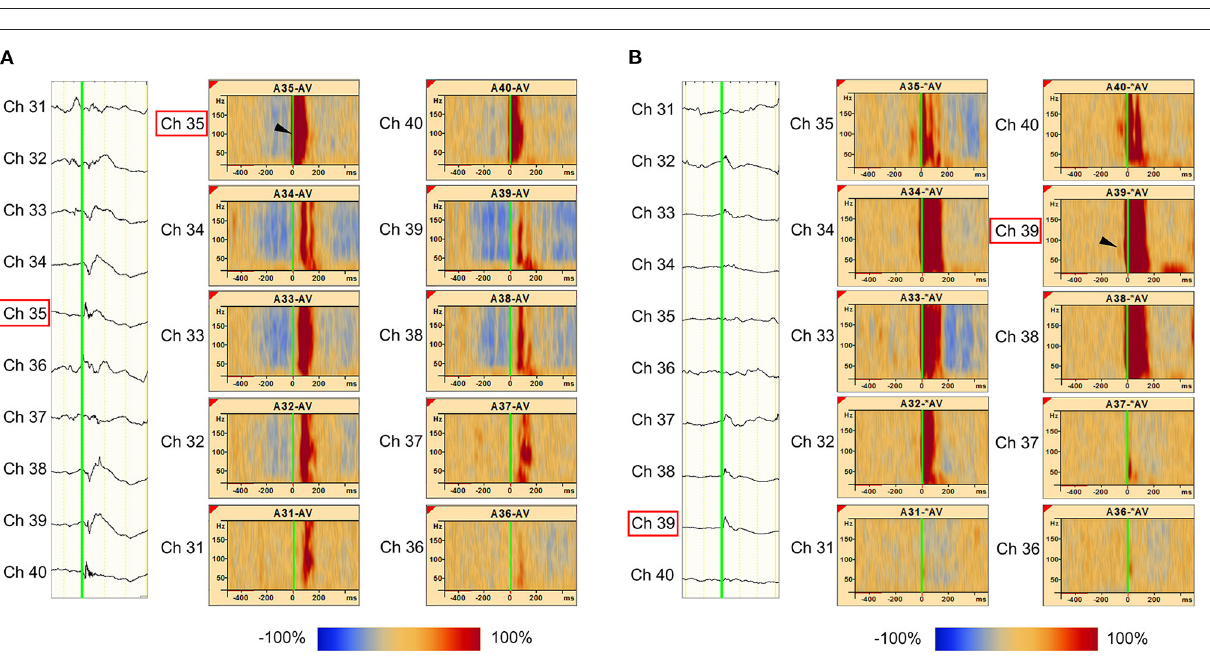
FIGURE 2 | Ch B12, and Ch B14 spikes. ( A , right) The Ch B5, Ch B6, Ch B12, and Ch B14 spike-related HFOs are shown at the top, second from top, third from top, and at the bottom, respectively. The blue color indicates significant HFO attenuation and the red color indicates significant HFO augmentation in a given time–frequency bin relative to the reference period. At the top, the HFO onset of Ch B5 spike-related HFOs were observed as Ch B5 (red frame). In the other three channels, spike-related HFOs also have their onset in Ch B5 (blue frame). Thus, HFO onset can be accurately identified as Ch B5 by marking any channel (Ch B5, Ch B6, Ch B12, and Ch B14) over which the spikes spread. (B) Spike-related ripple onset in Ch B5. In our novel method, we defined significant HFO amplitude modulation as at least 40Hz in width and 20ms in duration. Spike-related ripple onset in Ch B5, with a latency of − 30ms, from 80 to 130Hz (red frame). The